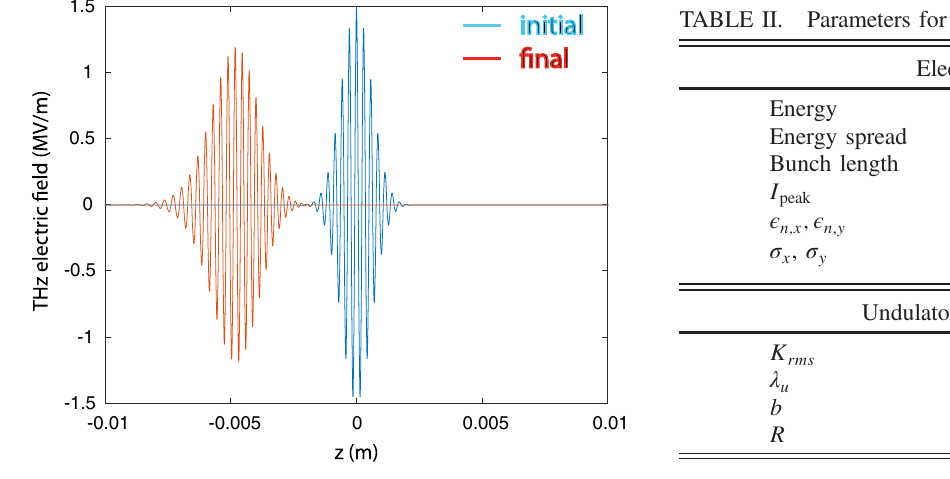
FIG. 9. GPT time-dependent simulation temporal field profile at the entrance and at the exit of the 1 m long waveguide. The shift in the peak corresponds to the group velocity difference from the speed of light which is matched to the electron beam longitudinal velocity in the undulator in the zero-slippage regime. Helical geometry. Radiation spectrum and temporal profile of the pulse along the undulator. Final longitudinal phase space.